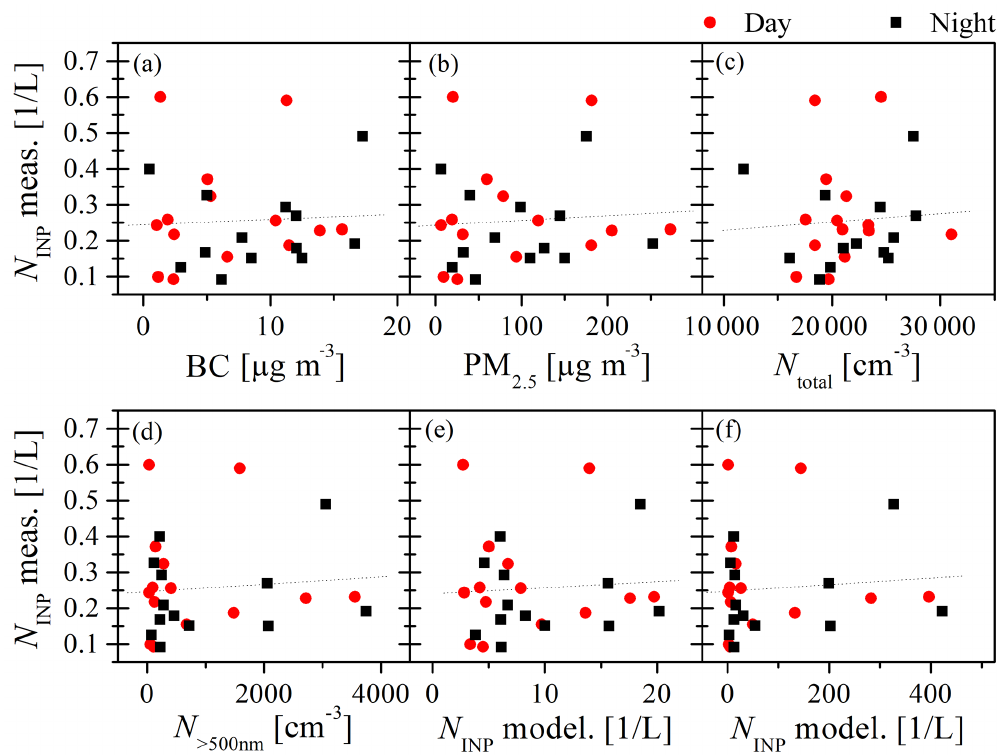
Figure 6. N INP at − 16 ◦ C as a function of mass concentrations of BC (a) and PM 2 . 5 (b) and of 12h average values of N total (c) . Furthermore, we show N > 500nm (d) and N INP at − 16 ◦ C derived based on DeMott et al. (2010) (e) and DeMott et al. (2015) (f) for daytime (red round symbols) and nighttime (black square symbols)